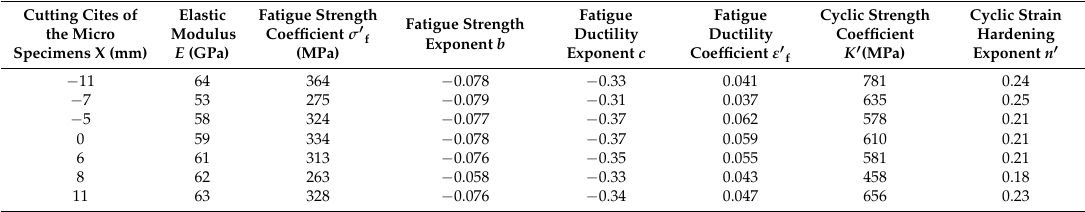
Table 3. Fatigue parameters of the welded